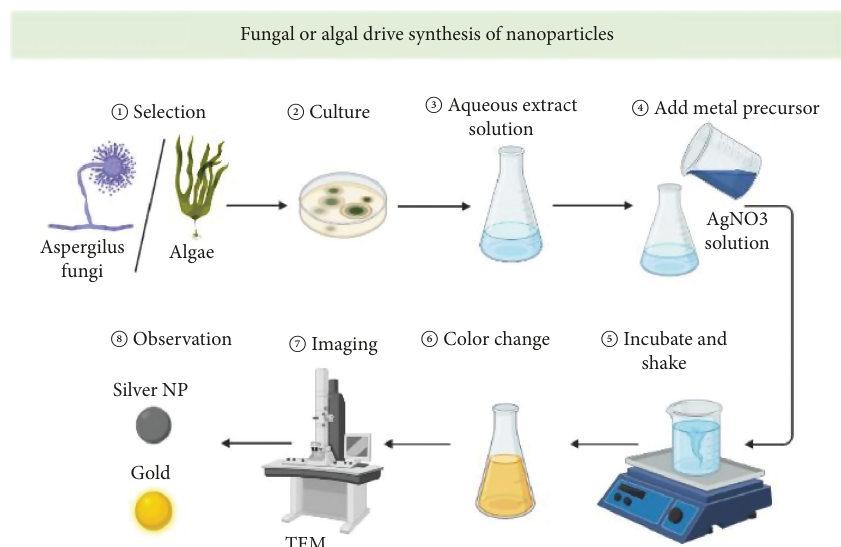
Figure 2: Fungal and algal synthesis of